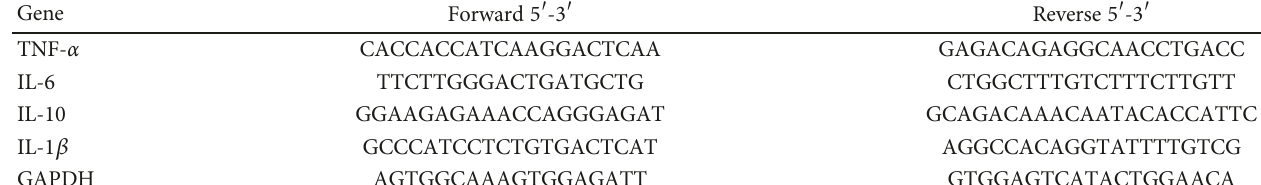
Table 1: The speci fi c primers used for ampli fi cation.